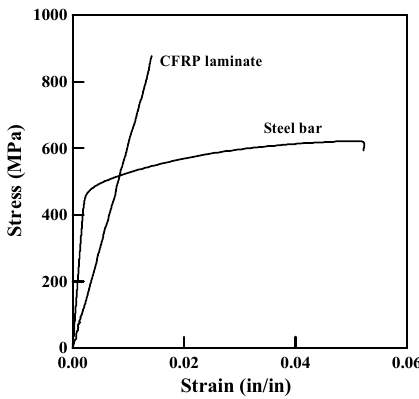
Figure 3. Stress-strain curves of CFRP laminate and steel bar.